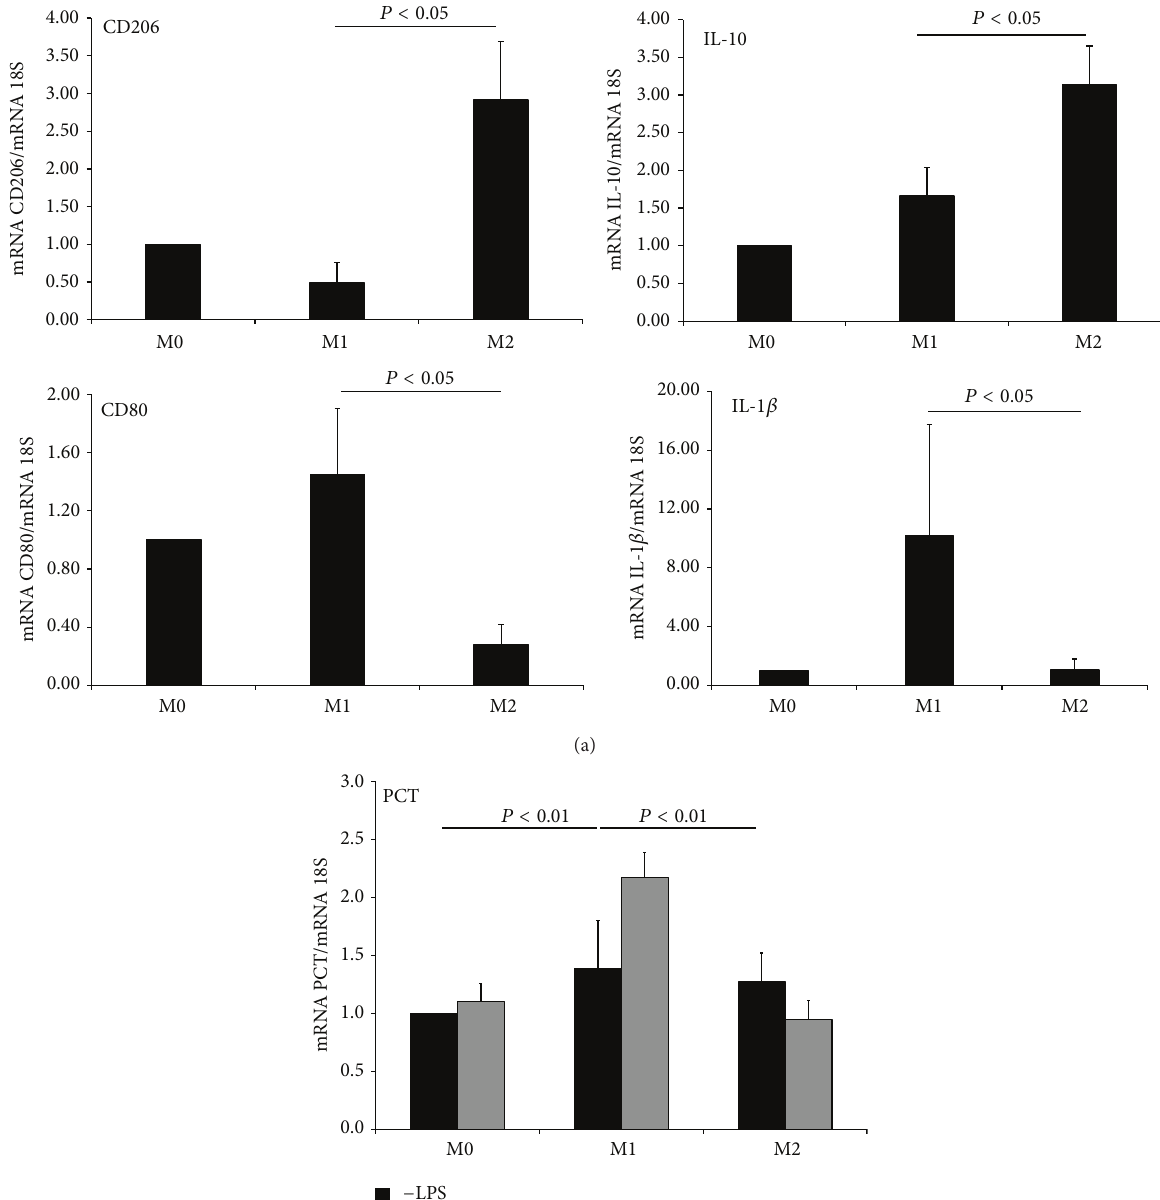
Figure 2: M1 polarized macrophages significantly upregulate the expression of PCT compared to both M0 and M2 macrophages under stimulation with LPS. (a) PMBCs were differentiated in culture for 7 days and polarized O/N with LPS (100ng/mL) and IFN 𝛾 (500U/mL) or IL-4 (20ng/mL) and IL-10 (50 ng/mL) for the M1/M2 polarization. mRNA expression levels of CD80 and IL-1 𝛽 (M1 markers) and CD206 and IL-10 (M2 markers) were measured by qPCR and normalized to those of the human housekeeping gene 18S. (b) RNA obtained from M0, M1, and M2 macrophages were quantified for PCT and 18S expression by qPCR. The relative amount of mRNA for PCT was normalized with reference to 18S value. Results were expressed as AUs, in which 1AU represents the value obtained with untreated macrophages used as a positive control. Bars represent the mean ± S.E.M. of at least 3 independent experiments. ∗ 𝑃 < 0.05 and ∗∗ 𝑃 < 0.01 (Mann-Whitney test).